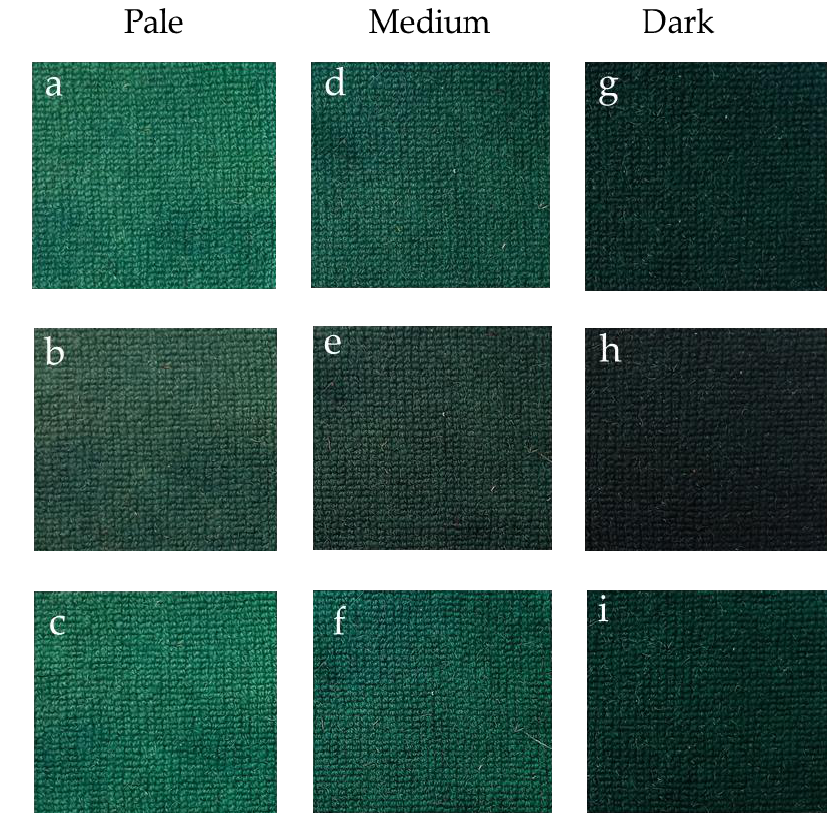
Figure 8. Images of the carpet 1 under different illuminants. Image ( a , d , g ) refers to the views under D65 (noon daylight), images ( b , e , h ) refers to refers to the views under A (incandescent) and images ( c , f , i ) refers to refers to the views under F02 (cool white fluorescent) for a certain carpet with three different shades (picture resolution: 4032 × 3024 pixels).